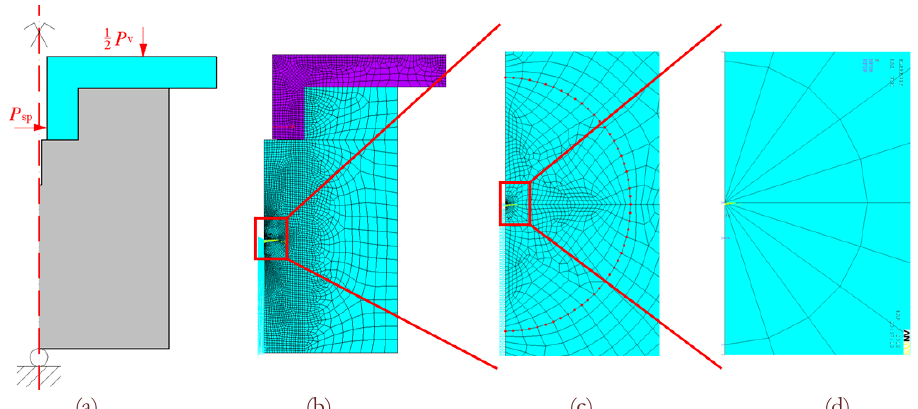
Figure 4: 2D representation of the WST – static scheme with indication of boundary conditions (a) and corresponding FE model (b). Example of the FE mesh around the crack tip: ring of selected nodes (at radius 5 mm from the crack tip) (c) and quarter-point crack- tip elements (d).